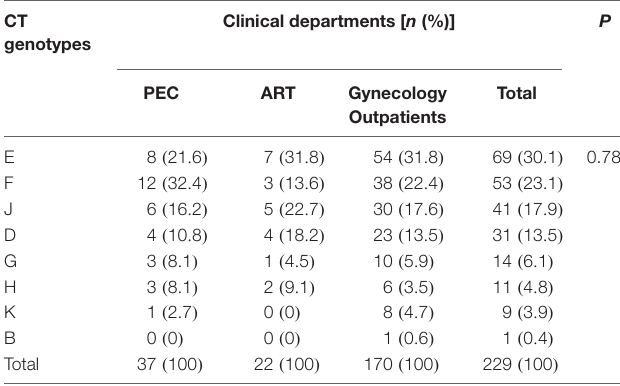
TABLE 3 | Genotype distribution of 229 urogenital Chlamydia trachomatis stains by clinical